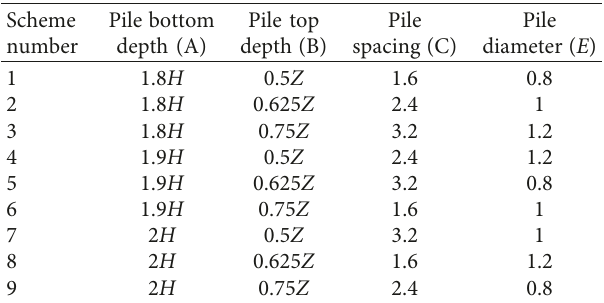
Table 14: Orthogonal experiment scheme of the numerical simulation.